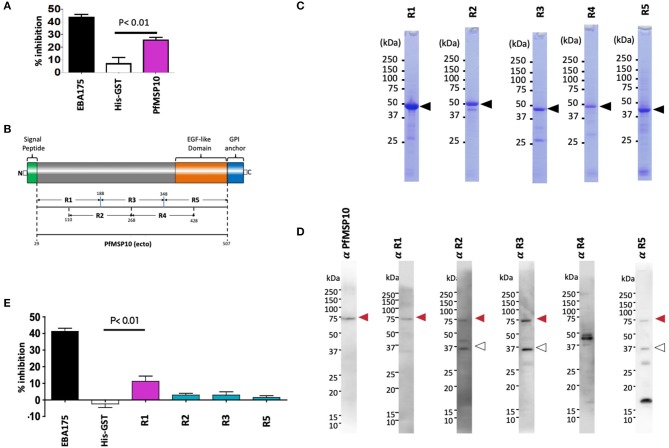
Anti-PfMSP10 antibodies have GIA activity. (A) GIA activity of 20 mg/ml rabbit anti-ecto-PfMSP10 antibodies. Rabbit anti-His-GST antibodies, and rabbit anti-EBA175 III-V antibodies were included as negative and positive controls, respectively. Bars indicate mean of three independent experiments, each performed in triplicate. Error bar represents the standard error of the mean. Statistically significant (student's t-test; p < 0.01) data relative to rabbit antibodies against His-GST is shown. (B) Schematic representation of ecto-PfMSP10 and 5 recombinant fragments that were synthesized. Numbers represent amino acid positions. The protein has a predicted N-terminal signal peptide (1–28 aa), an EGF like domain (shown in orange), and a C-terminal GPI anchor. Recombinant PfMSP10 truncates/regions were expressed as N-terminal GST-tagged proteins by the wheat germ cell-free system included region (R)1, amino acid D29-N188; R2, N110-E268; R3, I189-V348; R4, E269-R428; and R5, N349-Q507. (C) Purified recombinant GST-tagged PfMSP10 regions separated by 12.5% SDS-PAGE and stained with CBB. Arrowheads indicate molecular masses as predicted from amino acid sequences. (D) Reactivity of rabbit anti-PfMSP10 antibodies to native PfMSP10. Schizont-rich parasite pellet lysate was resolved under reducing conditions and probed with rabbit antibodies specific to each region. The additional bands (open arrowheads) represent processed fragments. (E) GIA activity of 20 mg/ml rabbit anti-PfMSP10 antibodies raised against each region. Rabbit anti-His-GST antibodies, and rabbit anti-EBA175 III-V antibodies were included as negative and positive controls, respectively. Bars indicate mean of two independent experiments, each performed in triplicate. Error bar represents standard error of the mean. Statistically significant (student's t-test; p < 0.01) data relative to rabbit antibodies against His-GST is shown.